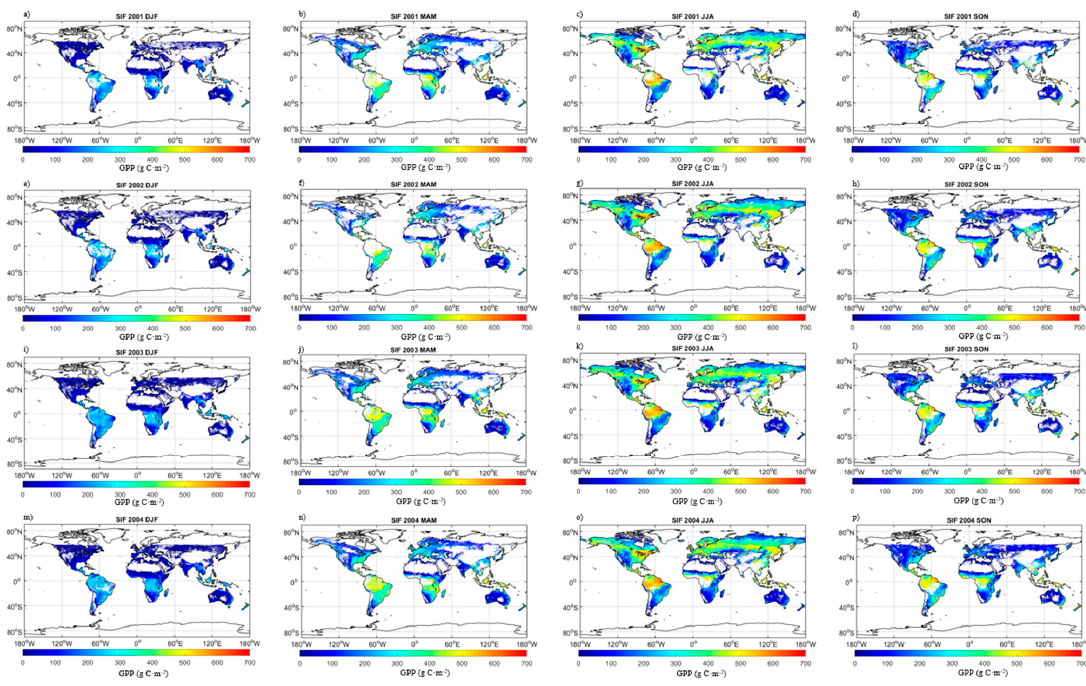
Figure A1. Spatial patterns of global GPP in different seasons: ( a ) GPP SIF in DJF of 2001; ( b ) GPP SIF in MAM of 2001; ( c ) GPP SIF in JJA of 2001; ( d ) GPP SIF in SON of 2001; ( e ) GPP SIF in DJF of 2002; ( f ) GPP SIF in MAM of 2002; ( g ) GPP SIF in JJA of 2002; ( h ) GPP SIF in SON of 2002; ( i ) GPP SIF in DJF of 2003; ( j ) GPP SIF in MAM of 2003; ( k ) GPP SIF in JJA of 2003; ( l ) GPP SIF in SON of 2003; ( m ) GPP SIF in DJF of 2004; ( n ) GPP SIF in MAM of 2004; ( o ) GPP SIF in JJA of 2004; ( p ) GPP SIF in SON of 2004.